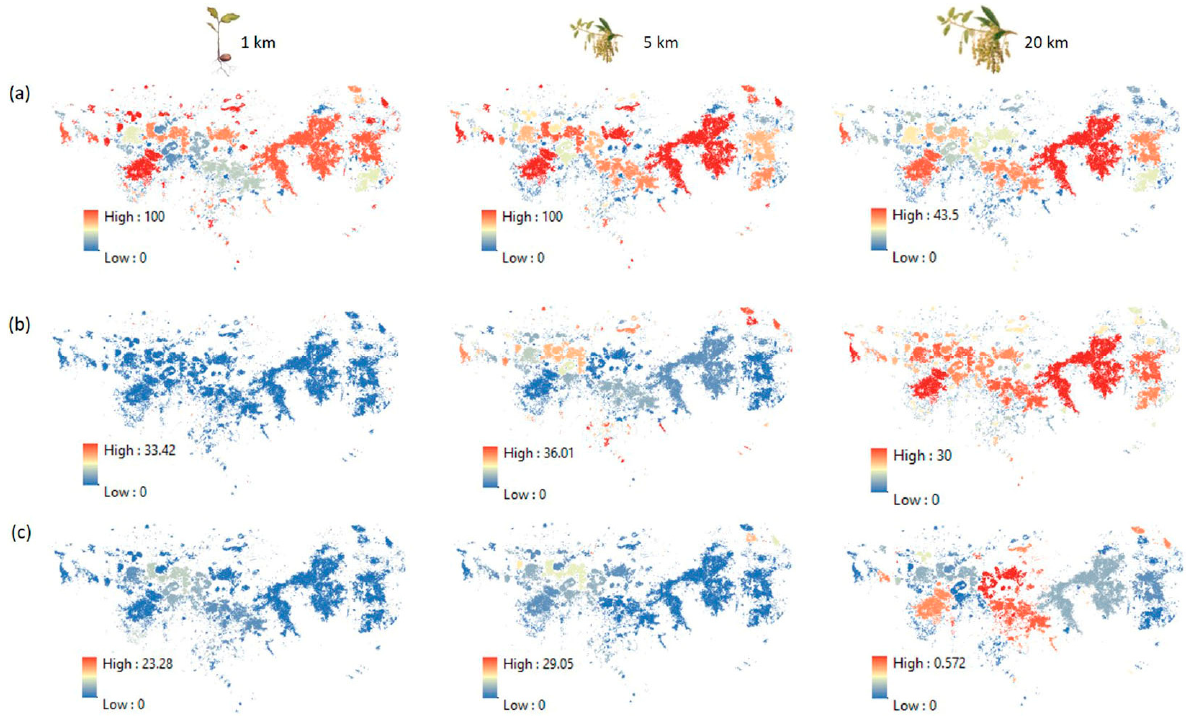
Figure 2. Maps of the temperate forest within the Avocado Belt of Michoacán, Mexico, showing the dIIC f intra ( a ), dIIC f flux ( b ) and dIIC f connector ( c ). Indices are shown for the dispersal distance thresholds of seeds (1 km) and pollen (5 and 20 km), considering the size as the patch attribute. Values of the indices are indicated by the color of the bars.